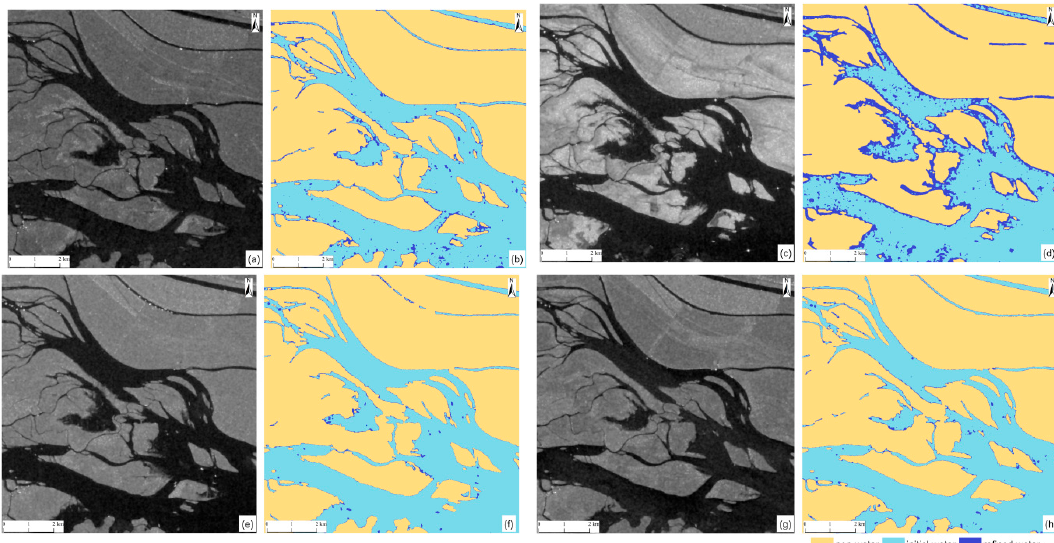
Figure 3. The initial water contours using tile-based KI thresholding method, refined water contours by the active contour model (ACM) model, and final extracted water inundations for validation site A; ( a ), ( c ), ( e ), and ( g ) show the initial and refined water contours, as well as the Sentinel-1 scene in VV polarization acquired on 23 May 2017, 22 July 2017, 20 September 2017, and 9 October 2018, respectively; ( b ), ( d ), ( f ), and ( h ) show the corresponding final water and non-water classification.